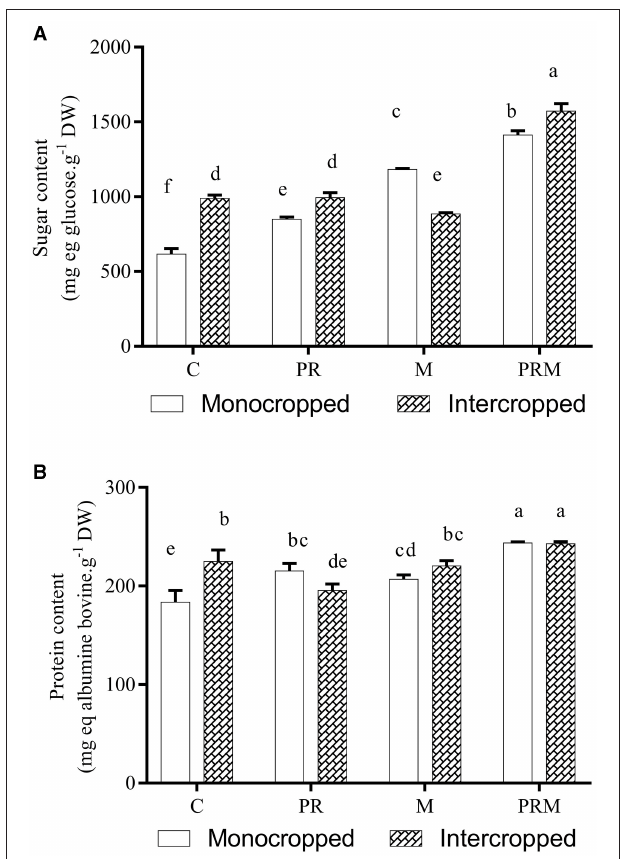
FIGURE 2 | Effect of the intercropping system and inoculation with rhizobacteria consortium (PR), mycorrhizae (M), and their combination (PRM) on (A) wheat sugar and (B) protein content after 5 months of growth under field